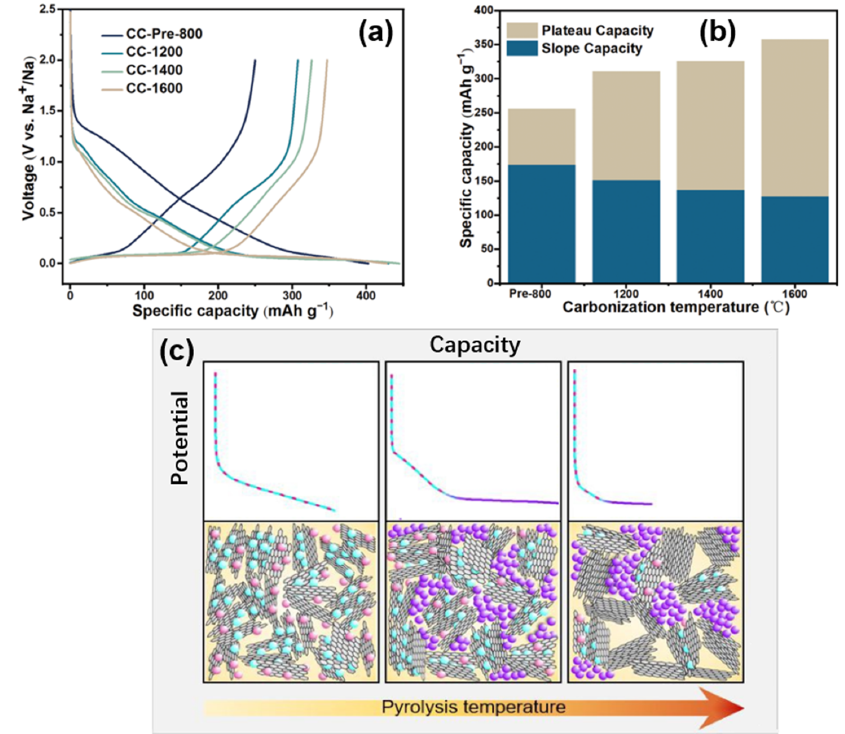
Figure 8. ( a ) Galvanostatic initial discharge and charge curves of cock-derived HC (prepared at different pyrolytic temperatures) at a current rate of 0.1 C (30 mA g −1 ). ( b ) Specific capacity of cock-derived HC from the different plateau (<0.15 V) and slope (>0.15 V) contributions (discharge capacity at the 2nd cycle) [67]. ( c ) Simple schematic illustration of the proposed sodium storage mechanism [68].